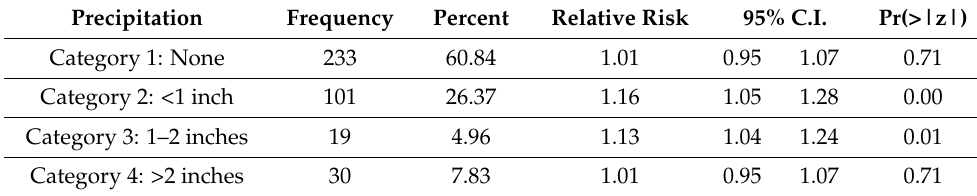
Table 2. Distribution of daily